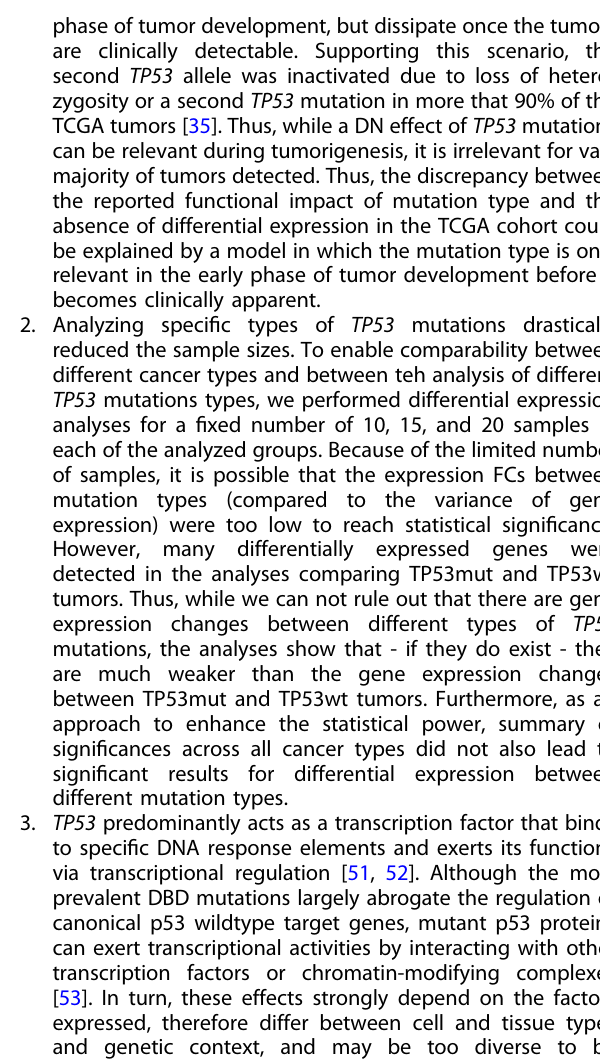
Fig. 7 Immune cell population in the tumor microenvironment. Signi fi cant changes in immune cell abundance (FDR = 10%) between TP53mut and TP53wt tumors are coded in colors. Red = higher abundance in TP53mut tumors. Gree n = lower abundance in TP53mut